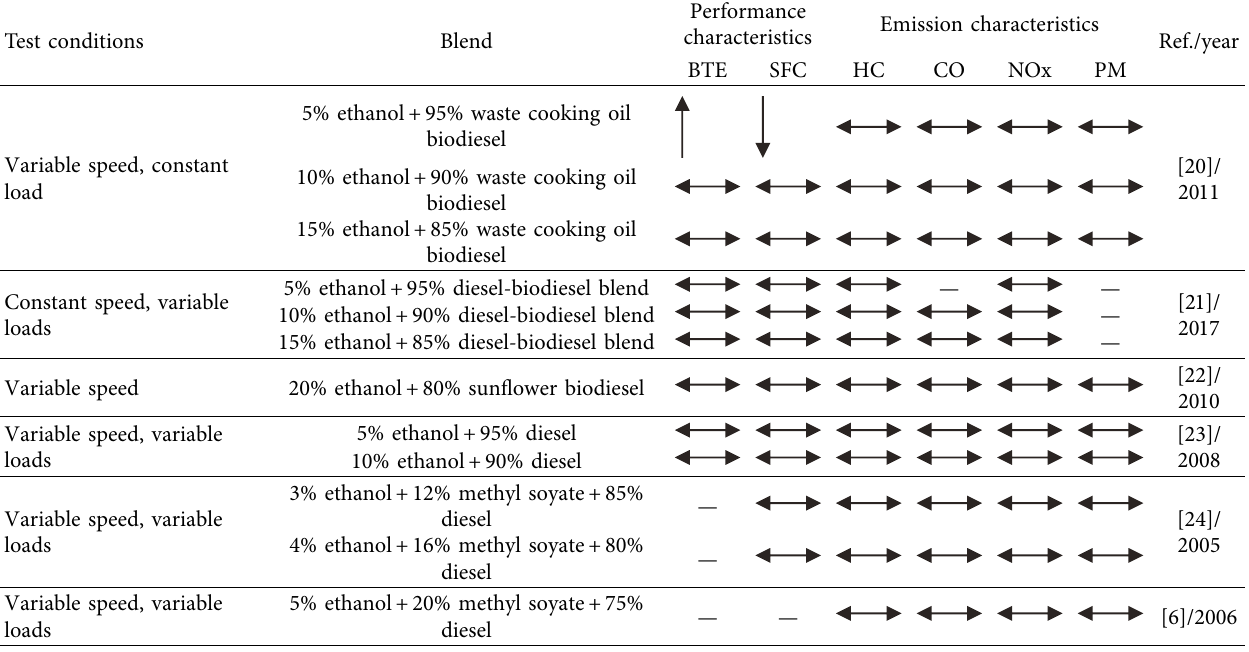
Table 1: Performance and emission characteristics of various alcohols bend with diesel.